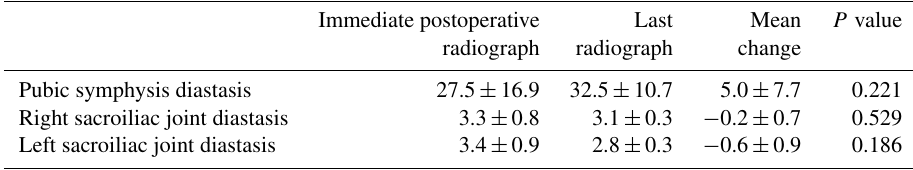
Immediate postoperative